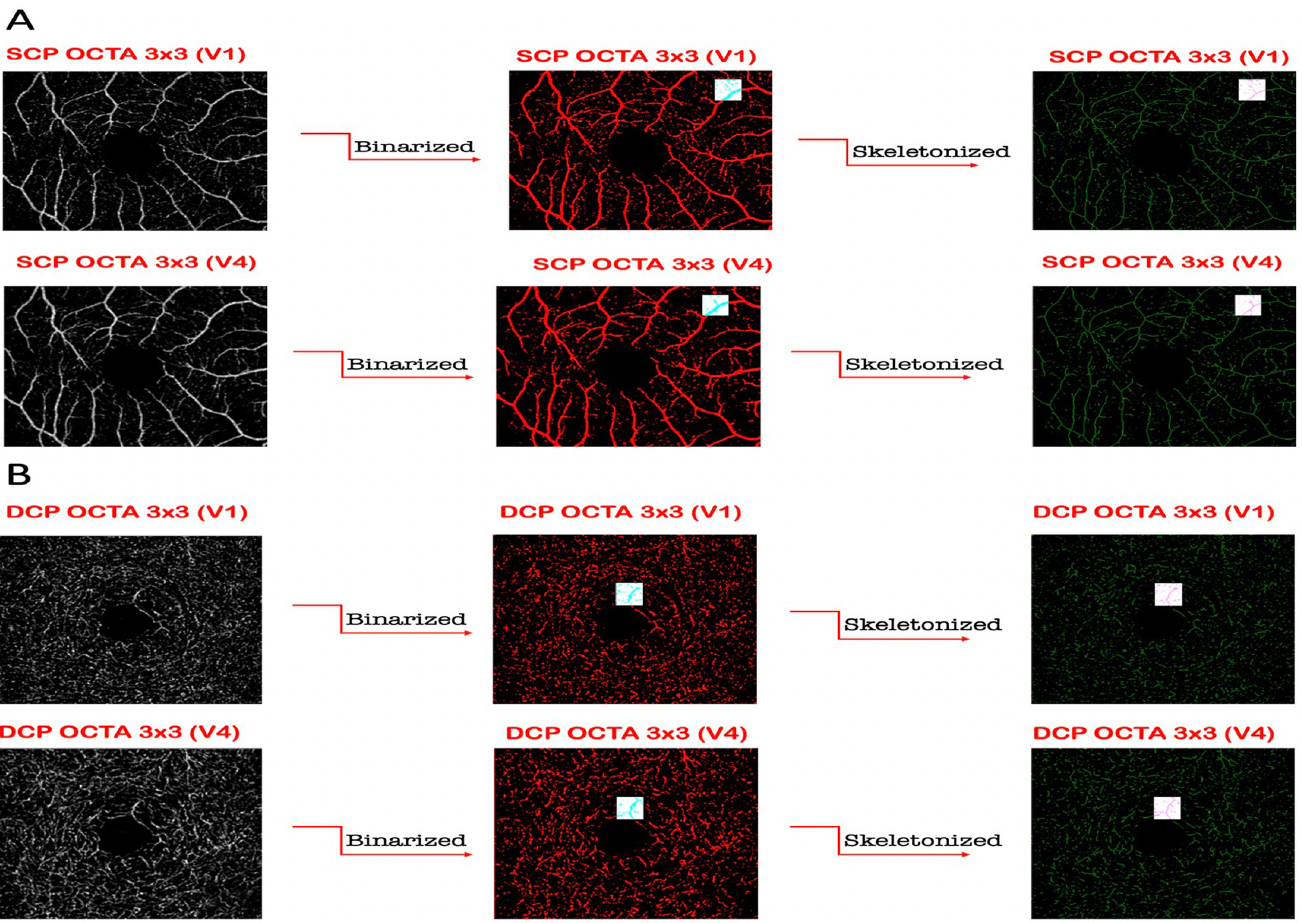
Fig 2. Panel A: Representation of the OCTA assessment of the superficial capillary plexus (SCP). The SCP was investigated in two different OCTA scan modalities: (i) 3x3-mm single volume scan (V 1 ) (Top left), and (ii) 3x3 multiple-volume scan (V 4 ) (bottom left). The SCP binarized (middle) and skeletonized (right) images, for both protocol scans, were analyzed to investigate both perfusion density (PD), and vessel length density (VLD), respectively. Panel B: Representation of the OCTA assessment of the deep capillary plexus (DCP). The DCP was investigated in two different OCTA scan modalities: (i) 3x3-mm single volume scan (V 1 ) (top left), and (ii) 3x3 multiple-volume scan (V 4 ) (bottom left). The DCP binarized (middle) and skeletonized (right) images, for both protocol scans, were analyzed to investigate both perfusion density (PD), and vessel length density (VLD), respectively.